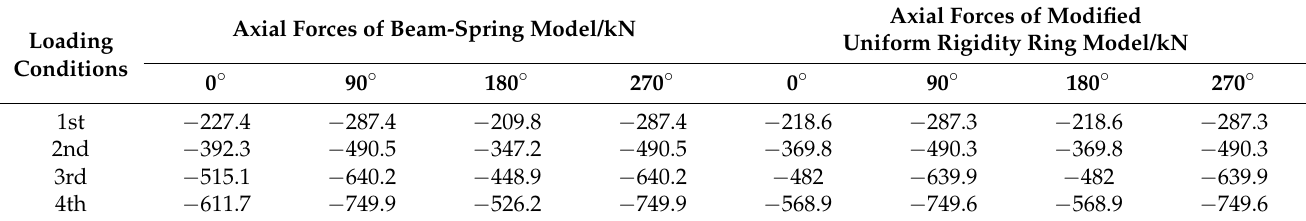
Table 9. Simulated axial forces under different loading conditions (unit: